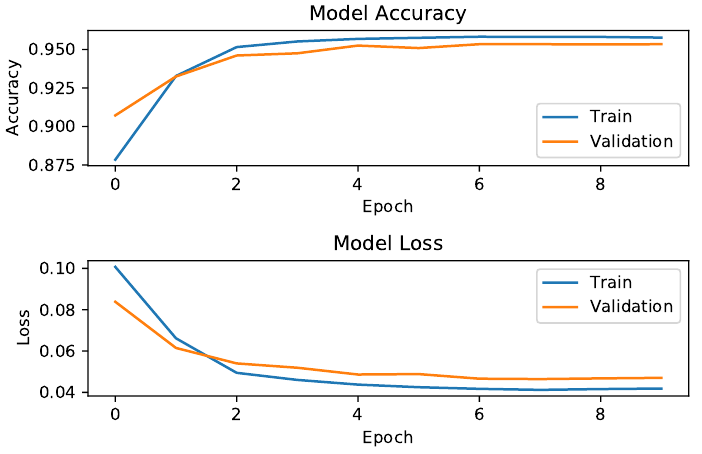
Figure 16. The training graphs for the Siamese-LSTM network with CASIA-A. The graph shows the training was successful with around 95% accuracy and 0.04 loss after 10